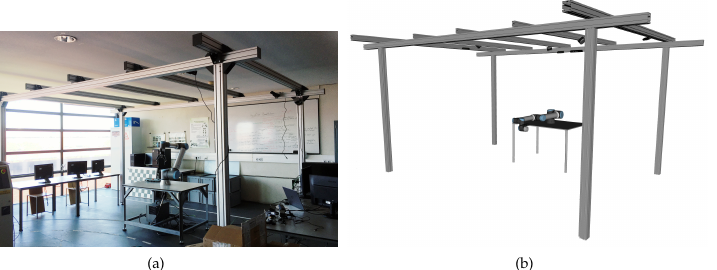
Figure 16. LARCC is a collaborative cell with a robotic manipulator, three RGB cameras, three 3D LiDARs, and one depth camera [17]. ( a ) represents the real system and ( b ) represents the simu- lated system.